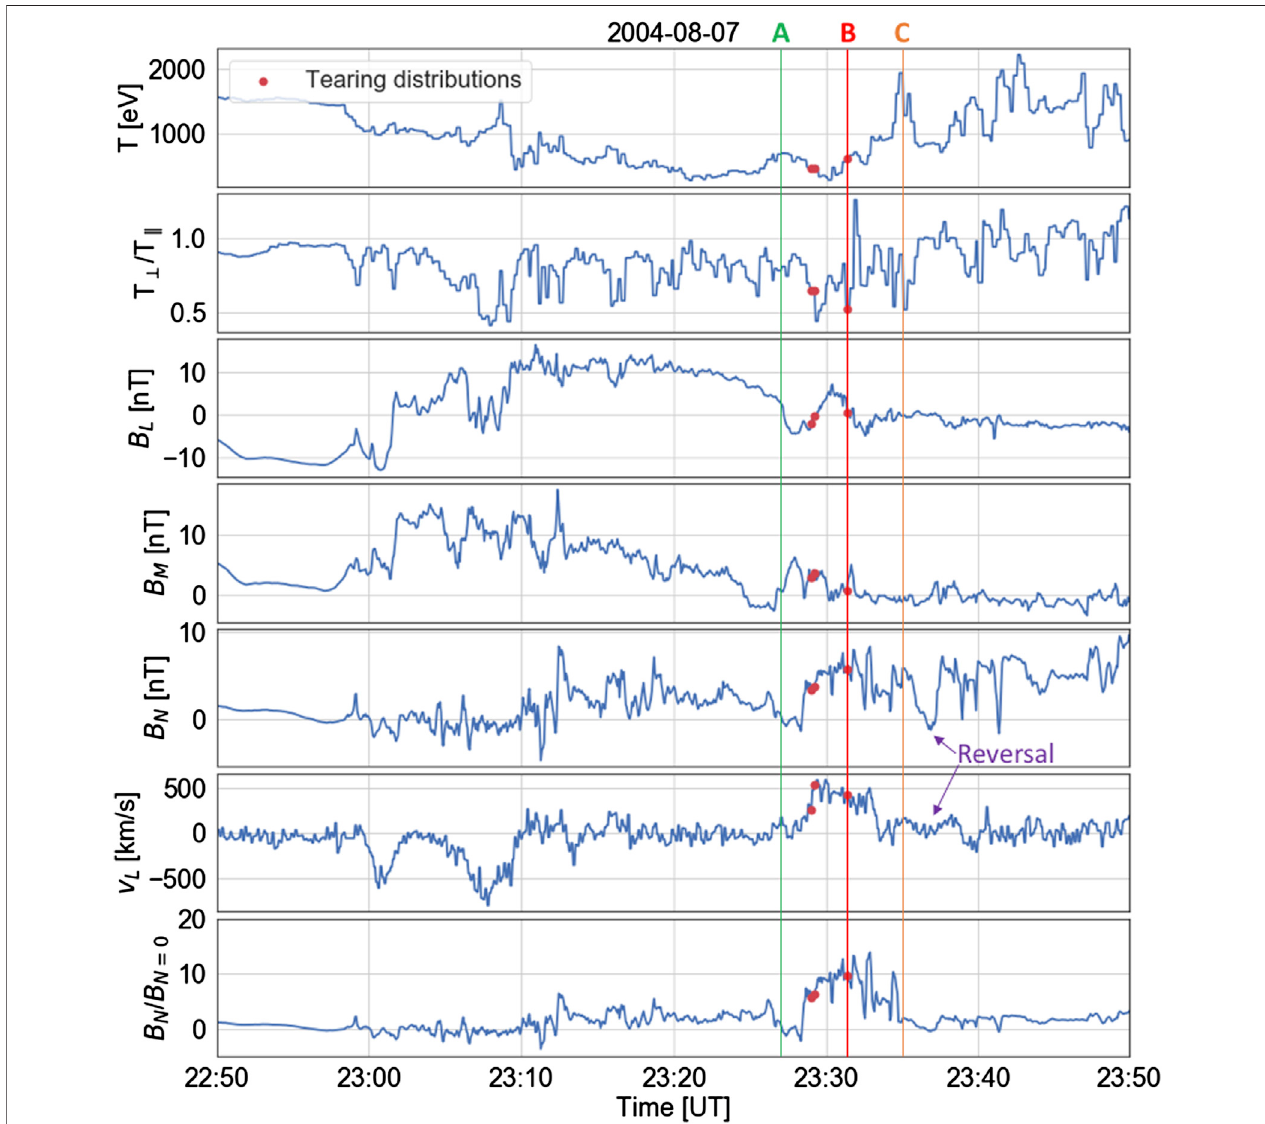
FIGURE 3 | Spacecraft measurements indicating the presence of the tearing instability. The plasma and magnetic fi eld parameters obtained by the C4 spacecraft across times 22:50:00 – 23:50:00 UT on 07/08/2004. From top to bottom: electron temperature, electron T ⊥ / T (cid:3) , magnetic fi eld in the L, M, N -directions respectively (in local magnetic coordinates), plasma fl ow velocity in the L -direction, and the B N / B N =0 ratio. A fl ow reversal is highlighted in the B N and v L panels. The red points indicate times of the tearing distributions identi fi ed by our outlier detection method. The lines labelled A, B, and C represent times of pre-tearing, tearing, and post-tearing distributions respectively. We show the distributions measured at these times in Figure 4